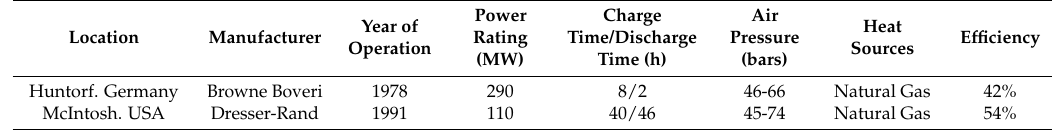
Table 5. Information data about the commercial CAES facilities [10,19,58].